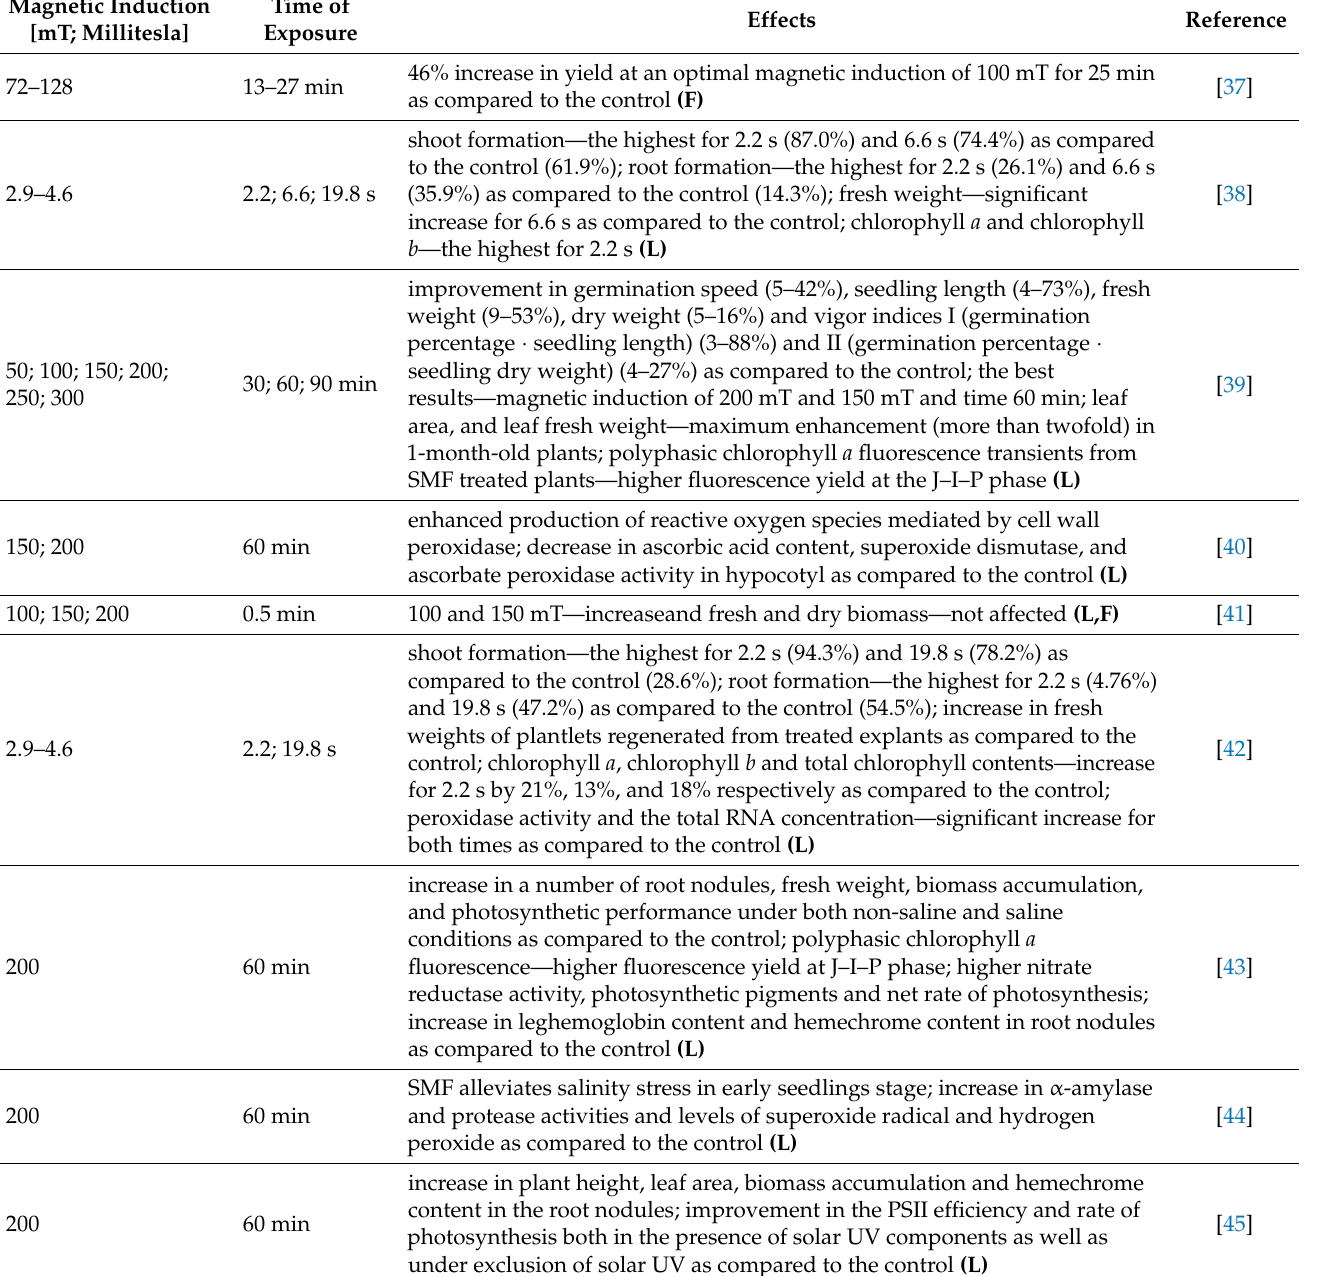
Table 2. The effects of SMF on soybean